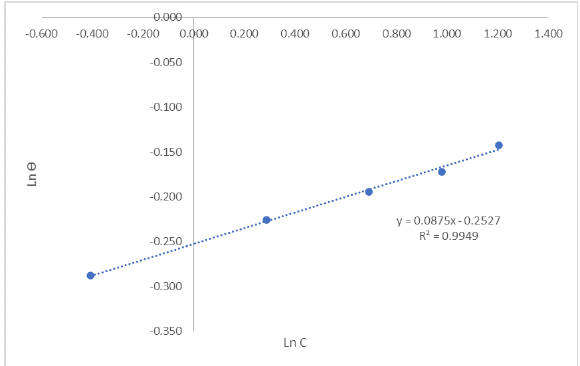
Fig. 9. Freundlich isotherm plot for the inhibitor’s adsorption of CPP on mild steel surface in 1.0 M HCl at 24 hour immersion time.